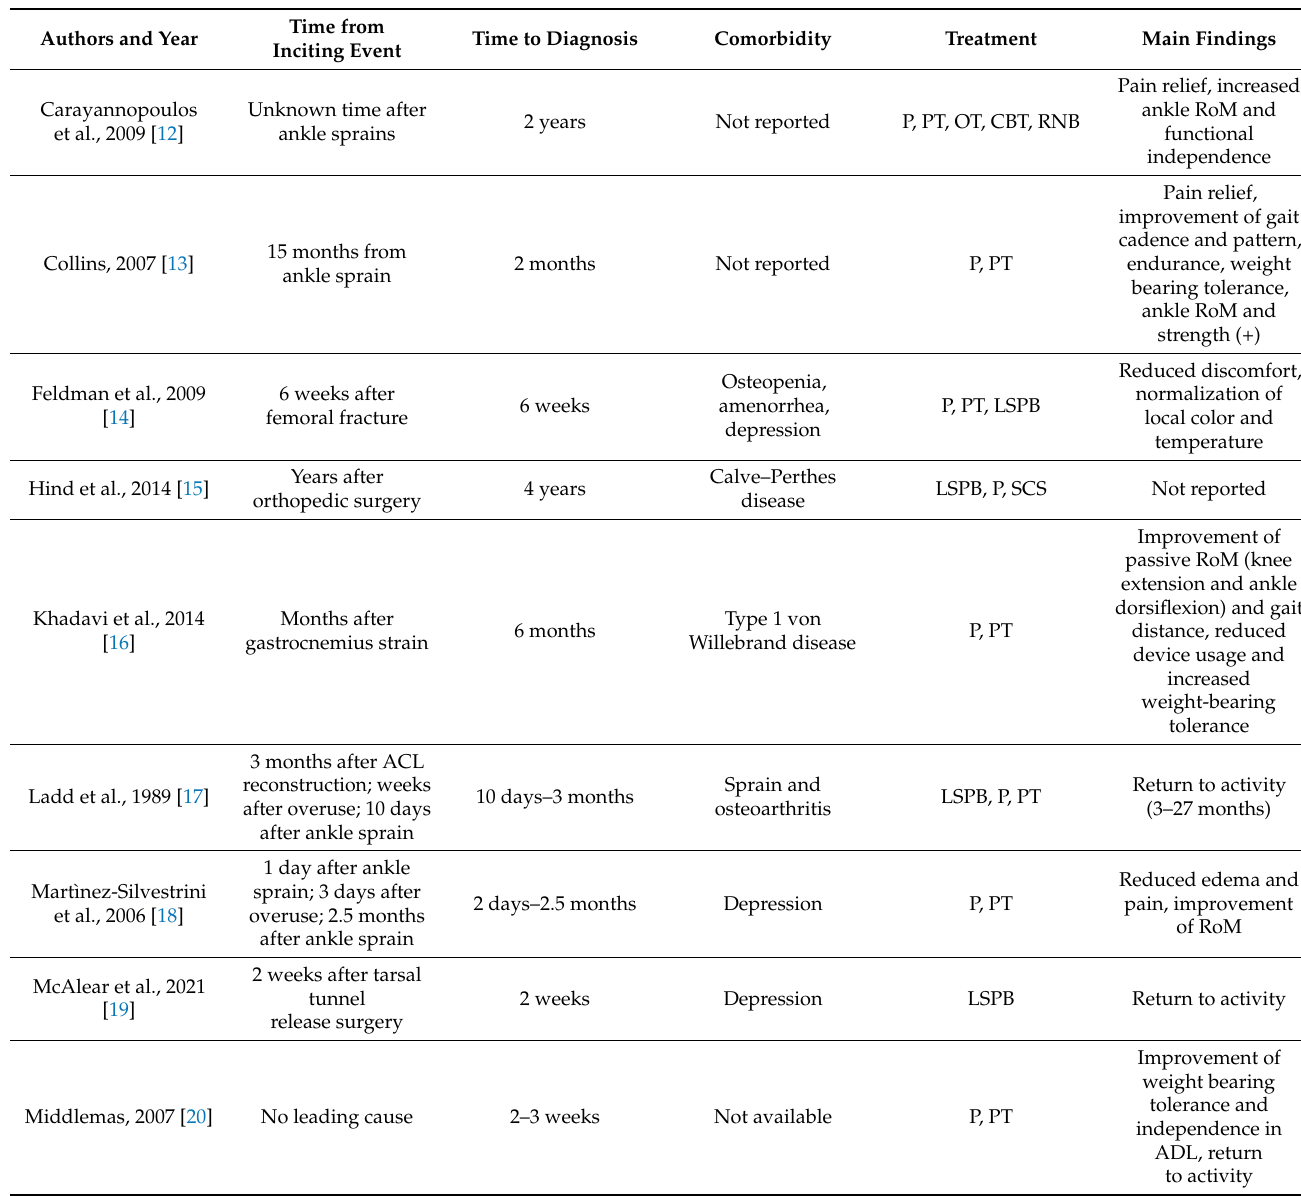
Table 2. Detailed information of the selected studies, including time to diagnosis, site, comorbidity, treatment, and outcomes. Authors and Year Treatment Main